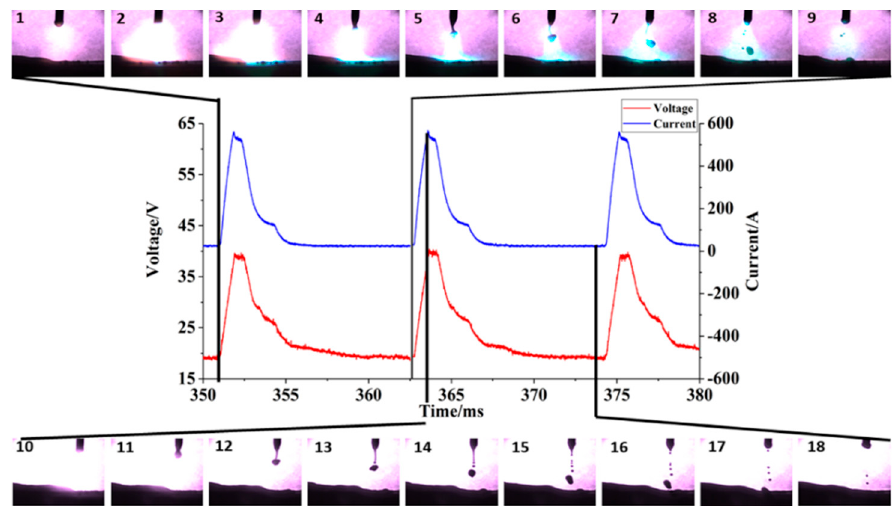
Figure 7. Combination of arc behavior, droplet transition behavior and electrical signals: 1–9 are the arc profile, 10–18 are images of the droplet transfer process (No.3).